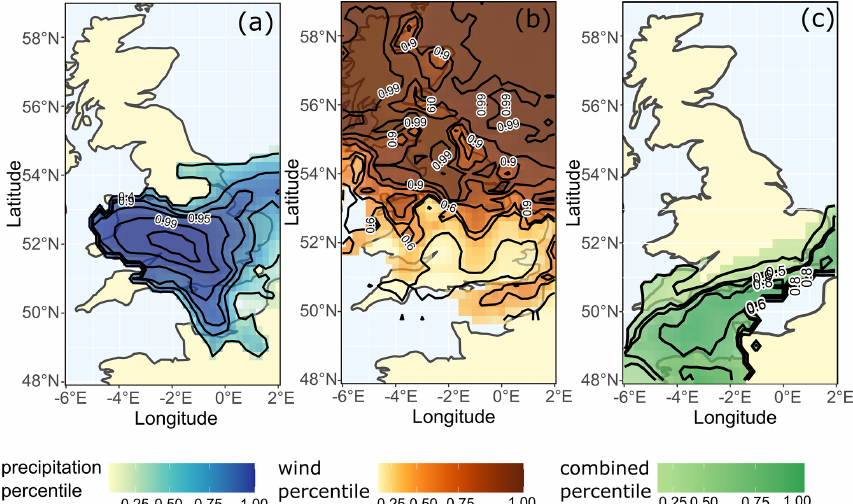
Figure 12. Footprint and intensity of precipitation and wind clusters (from the ERA5 Hazard Clusters Database 1979–2019, Supplement 3) associated with three significant events from our Great Britain Significant Weather Events Catalogue 1979–2019 (Supplement 4). The foot- print as a function of intensity for all pixels for each of these three events is given: (a) Catalogue Event 130, extreme precipitation (Hazard Cluster Database P12593); (b) Catalogue Event 146, extreme wind, associated with Storm Xaver (Hazard Cluster Database W5423); (c) Cat- alogue Event 154, compound wind and precipitation event associated with Storm Angus (Hazard Cluster Database